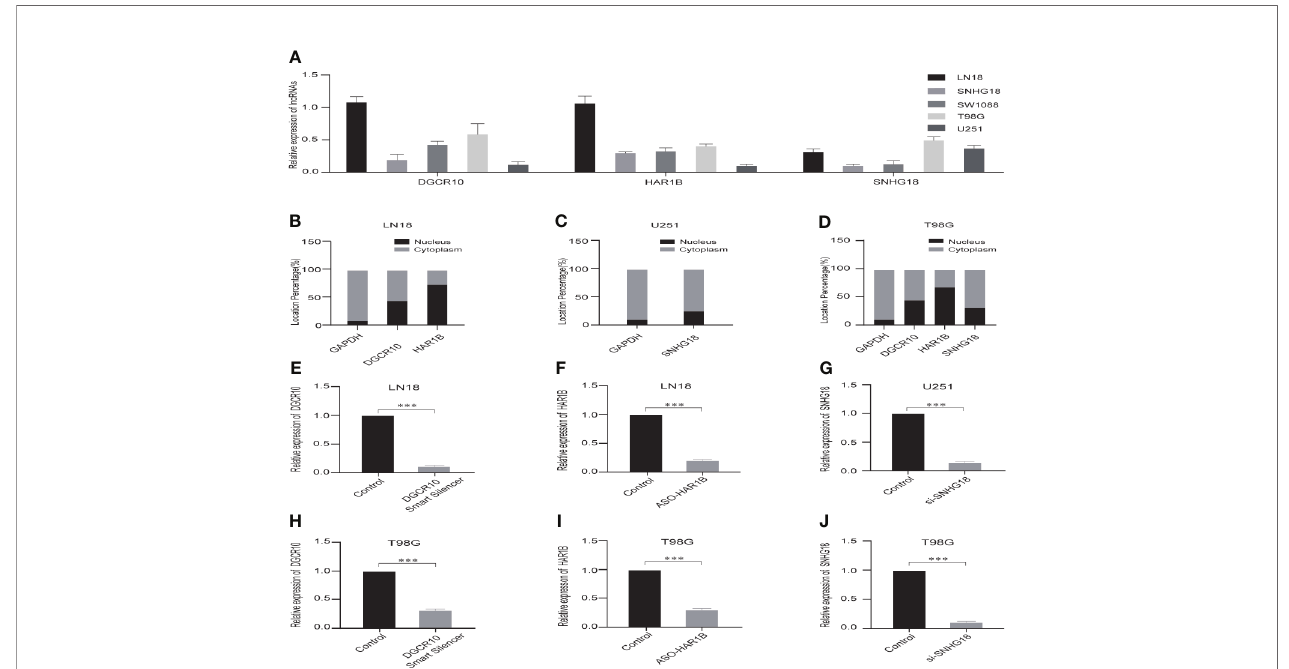
FIGURE 9 | Selection of cell lines and veri fi cation of the knockdown effect. (A) Relative expression levels of DGCR10, HAR1B, and SNHG18 in fi ve cell lines. (B) The nuclear and cytoplasmic percentage of DGCR10 and HAR1B in LN18 cells. (C) The nuclear and cytoplasmic percentage of SNHG18 in U251 cells. (D) The nuclear and cytoplasmic percentage of DGCR10, HAR1B, and SNHG18 in T98 cells. (E) The relative expression level of DGCR10 in LN18 cells after knockdown. (F) The relative expression level of HAR1B in LN18 cells after knockdown. (G) The relative expression level of SNHG18 in U251 cells after knockdown. (H) The relative expression level of DGCR10 in T98G cells after knockdown. (I) The relative expression level of HAR1B in T98G cells after knockdown. (J) The relative expression level of SNHG18 in T98G cells after knockdown. ***p < 0.001.